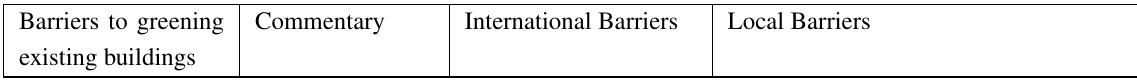
Table 3. Barriers to greening existing